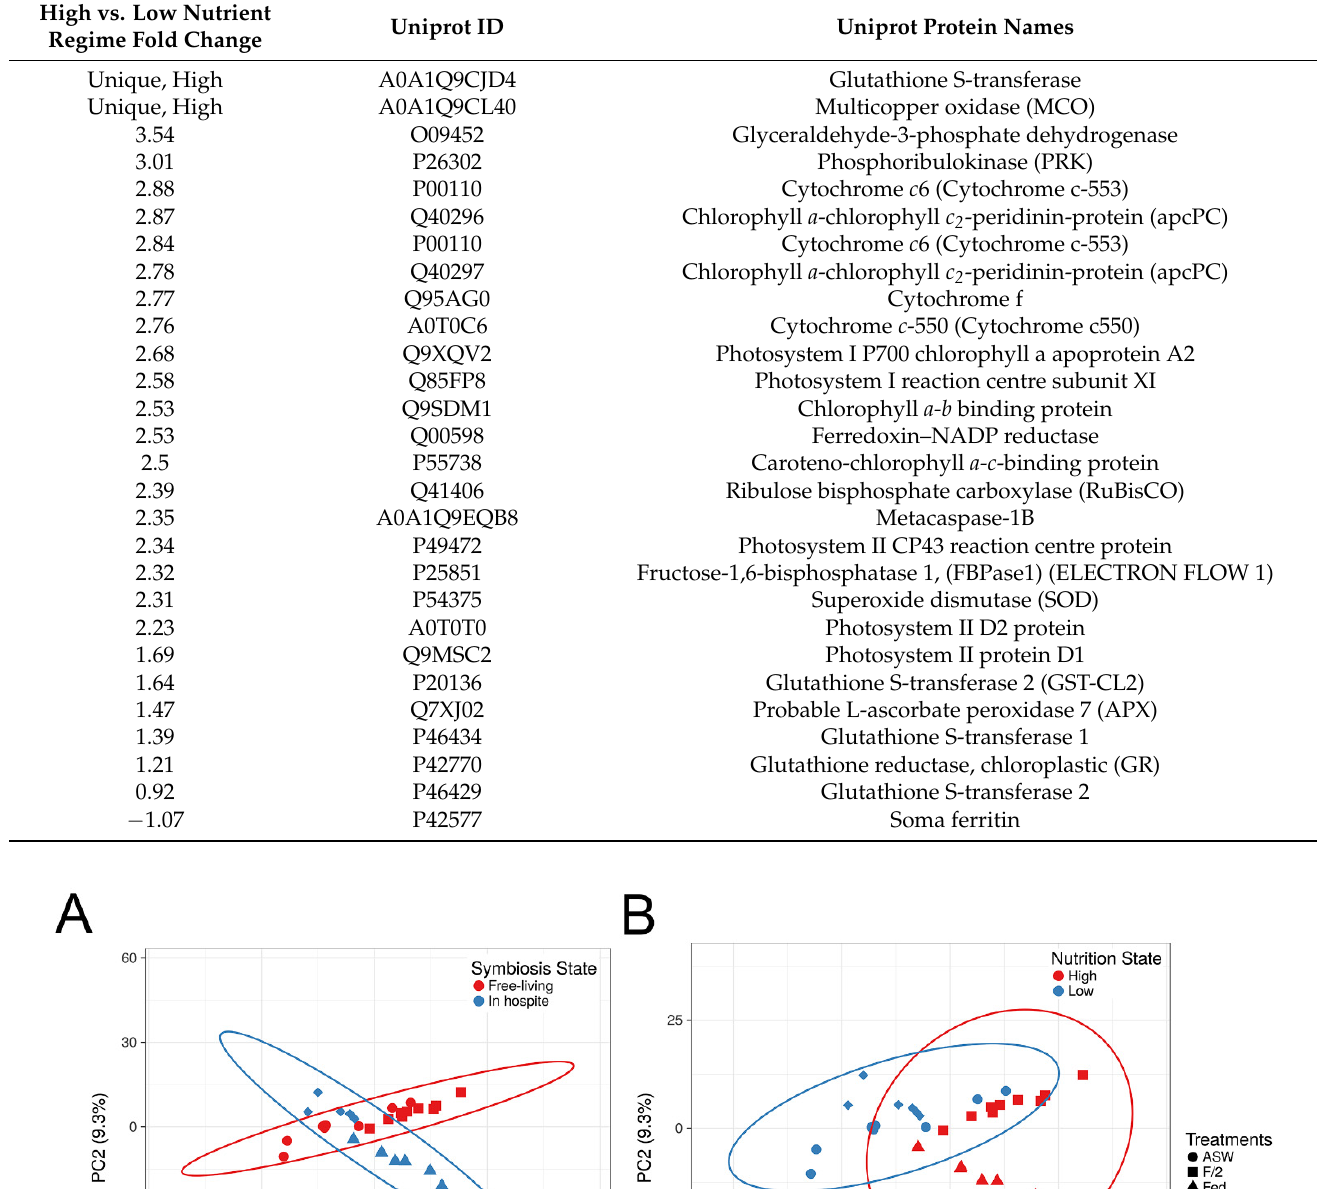
Table 2. Summary of proteins that are differentially abundant (FDR < 0.05) in Breviolum minutum when comparing high nutrient vs. low nutrient regimes (i.e., f/2 and well-fed treatments vs. ASW and starved treatments), in order of log 2 fold-change. Proteins shown here are those discussed in the text. The full list of proteins that were differentially expressed between high vs. low nutrient regimes is available in Table S3.